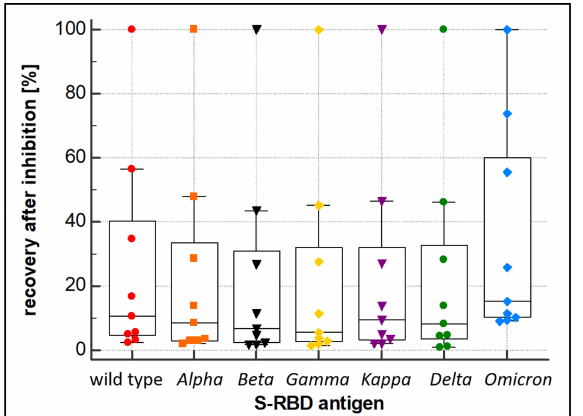
Figure 5. Inhibition behavior of the wild type, Alpha , Beta , Gamma , Kappa , Delta , and Omicron S-RBD variants. Inhibition was evaluated by quantification of an anti-SARS-CoV-2 antibody-containing sample after quenching with the recombinant wild type, Alpha , Beta , Gamma , Kappa , Delta , and Omicron S-RBD variant proteins,